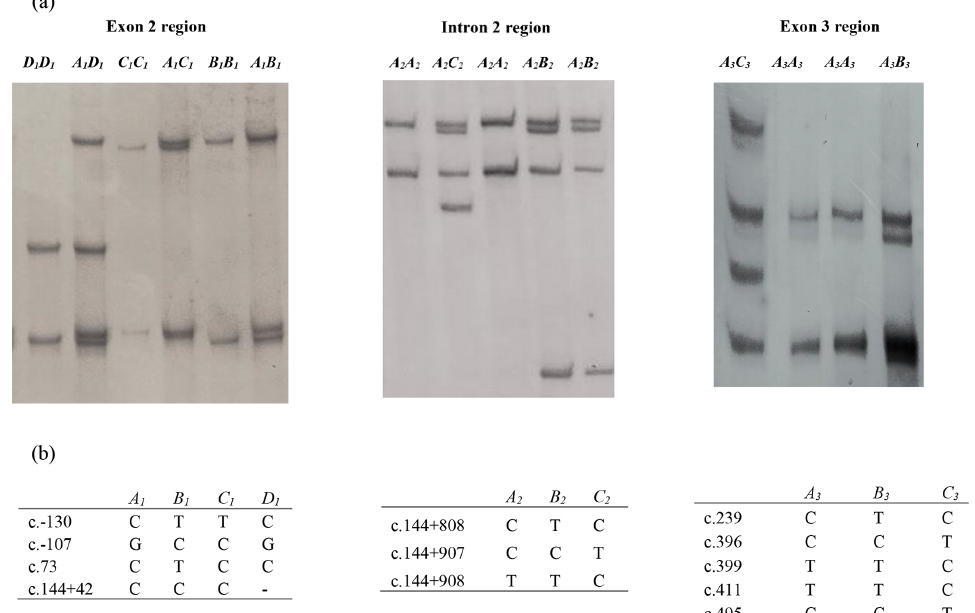
Figure 1. (a) Polymerase chain reaction–single strand conformation polymorphism (PCR-SSCP) banding patterns obtained for the three amplicons from the bovine leptin gene. (b) Nucleotide sequencing revealed the different sequence variations identified in each of these regions. A dash (–) represents a nucleotide deletion. Table 1. Variants and their respective frequencies identified in each of the three amplicons of bovine leptin gene across the NZ dairy and beef and the Nigerian dual-purpose cattle breeds investigated. Breed n Exon 2 region Intron 2 region Exon 3 region variants and variants and variants and frequencies (%) frequencies